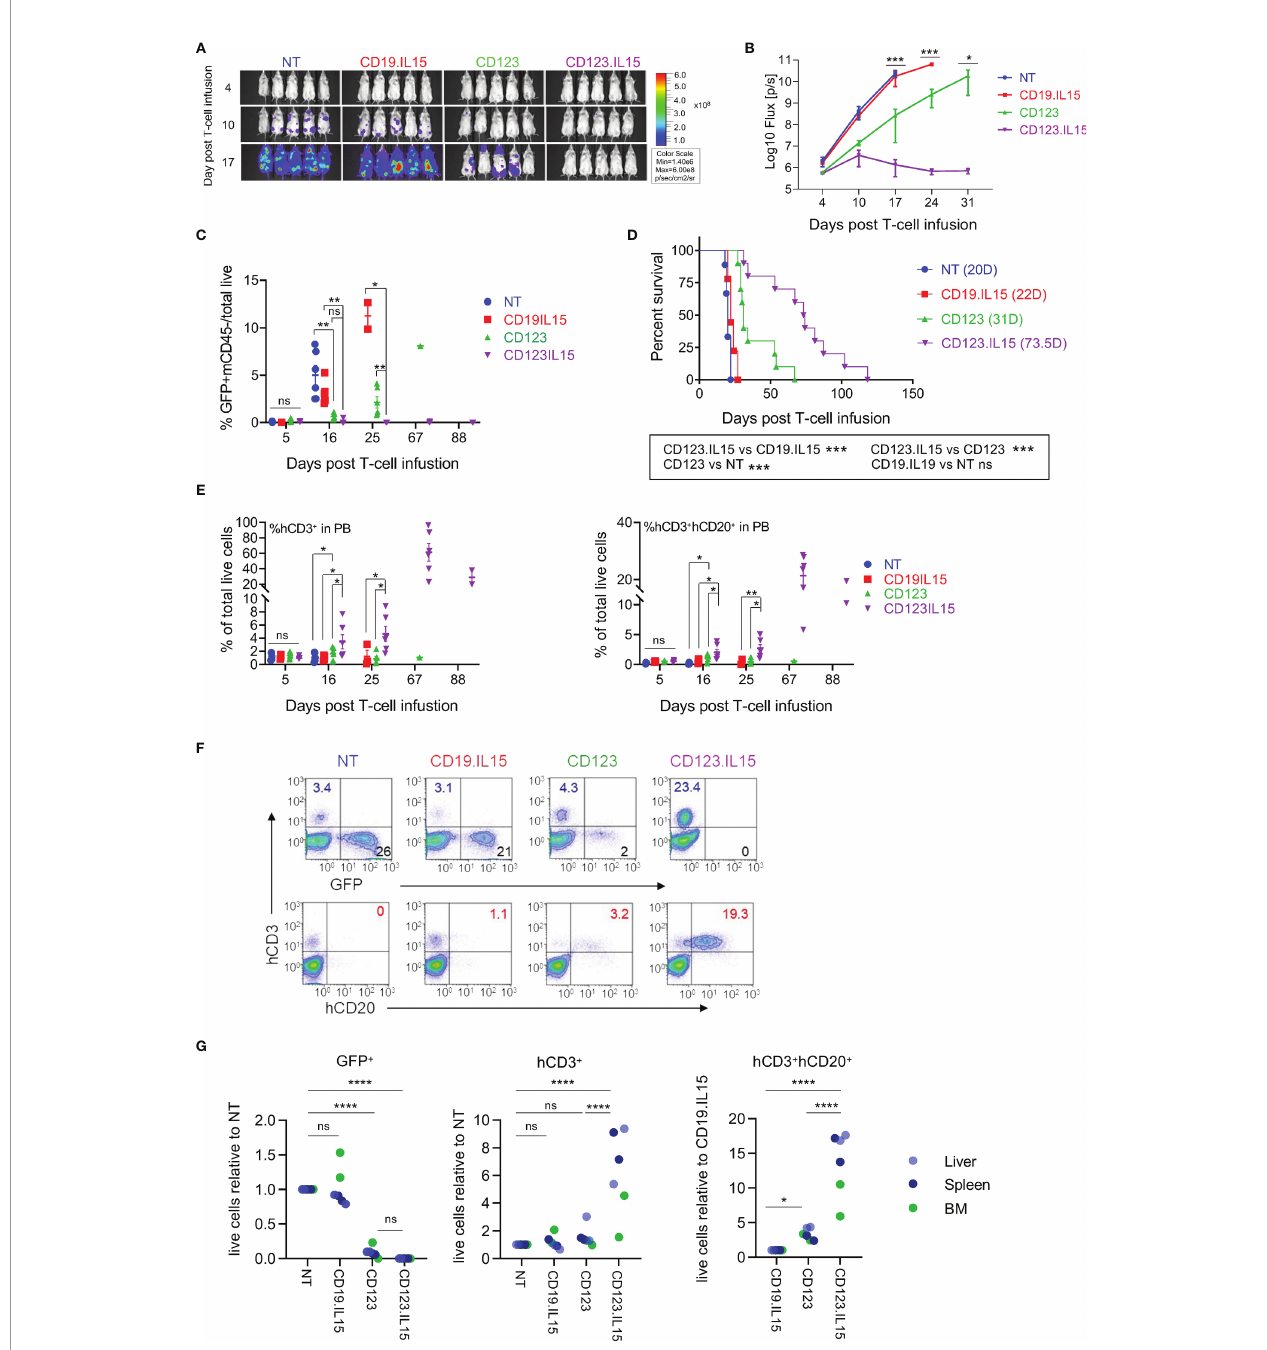
FIGURE 3 | IL15-expression in CD123-ENG T-cells results in enhanced persistence and improved anti-leukemia ef fi cacy in AML xenograft model. MOLM- 13.GFP.f fl uc-bearing NSGS mice received a single dose of 10 7 CD123-ENG.IL15, CD123-ENG, NT, or CD19-ENG.IL15 T-cells per mouse. MOLM-13 leukemia growth was measured by serial bioluminescence imaging (n = 9 to 11 mice per group). (A) Representative bioluminescence images. (B) Quantitative bioluminescence data. (C) Circulating number of GFP + /mCD45 - /total live MOLM-13 cells determined by fl ow cytometry analysis post T-cell infusion; data are shown as mean ± SE, ***: p <0.001, **: p <0.01, *: p <0.05, ns: not signi fi cant, t -test. (D) Kaplan – Meier survival analysis, ***: p <0.001, ns, non-signi fi cant, two- tailed log-rank Mantel – Cox test. (E) Circulating number of hCD3 + mCD45 − (left panel) and hCD3 + hCD20 + mCD45 − T-cells determined by fl ow cytometry analysis post T-cell infusion; data are shown as mean ± SE, **: p <0.01, *: p <0.05, ns, not signi fi cant, student t -test. (F, G) On day 20 two mice were euthanized of each group and the frequency of GFP + mCD45 − MOLM-13 AML, hCD3 + mCD45 − T-cells, and hCD3 + hCD20 + mCD45 − T-cells in liver, spleen, and bone marrow (BM) was determined. (F) Presentative fl ow cytometry analysis of spleen sample. (G) Relative frequency of GFP + mCD45 − MOLM-13 AML, hCD3 + mCD45 − T- cells, and hCD3 + hCD20 + mCD45 − T-cells in analyzed tissue, ****: p <0.0001, ns, not signi fi cant, two-way